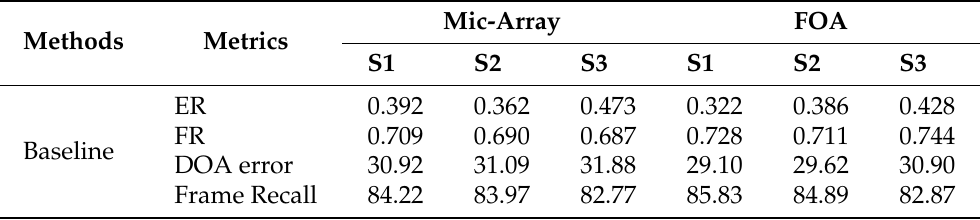
Table 3. Performance comparison between other similar methods and the proposed method in scenario-1 escalator ascending